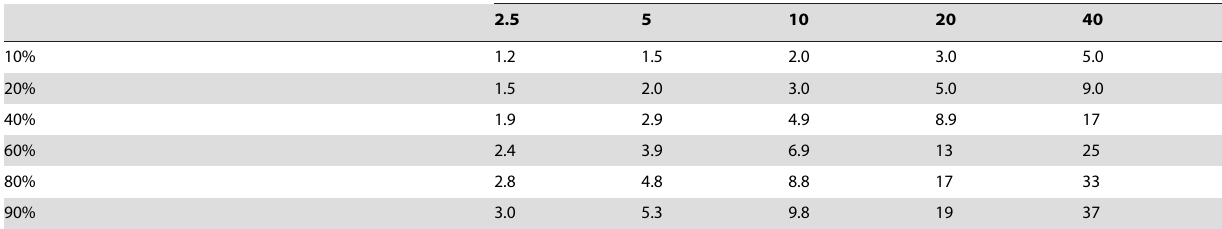
Table 2. Illustration of the cost per woman screened according to the cost of the DNA test, expressed as a multiple of the cost of an Integrated test, and the proportion of women who have a DNA test (i.e. positive based on a the first trimester stage of the Integrated test, 75% of the cost of the Integrated test incurred in the first